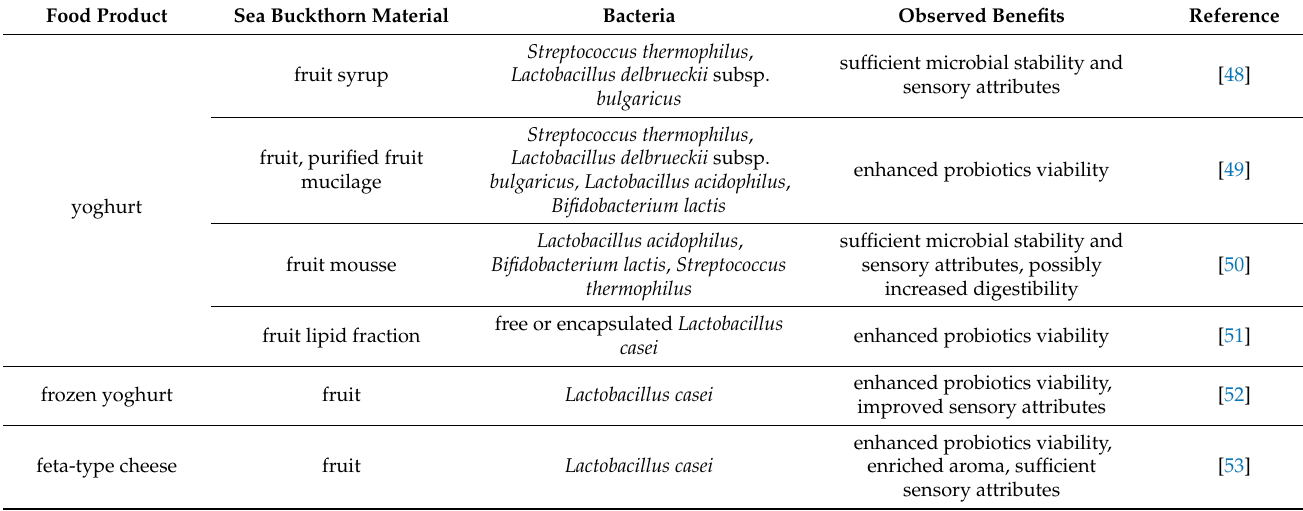
Table 2. Summary of studied probiotic dairy products containing sea buckthorn fruit or its component. Food